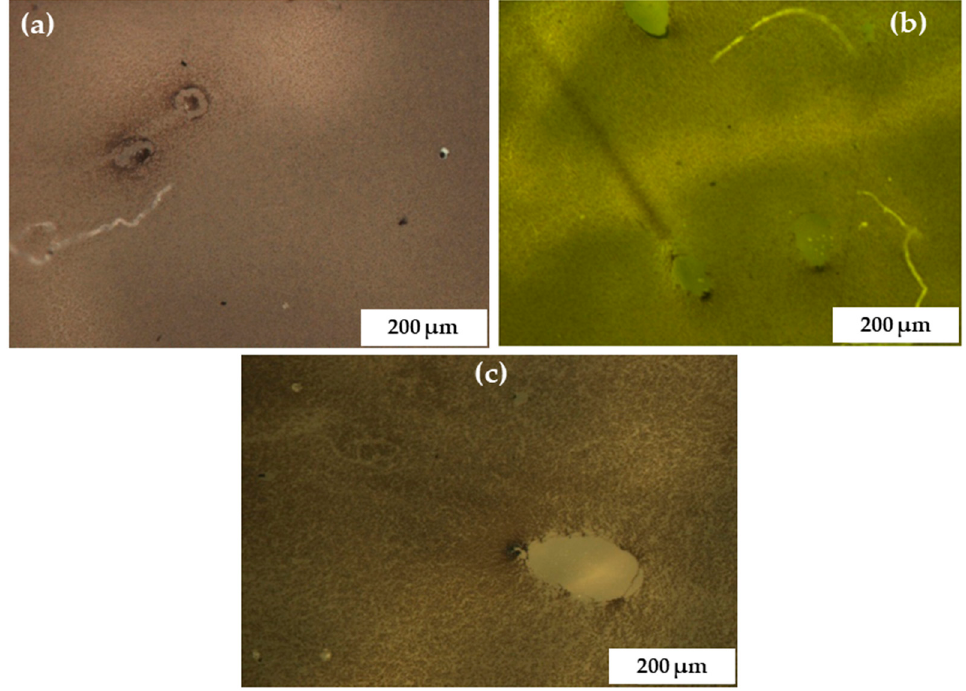
Figure 7. Light microscopic images recorded at calibration 90 of C-N-TiO 2 coated on glass support at a sol gel-solvent ratio varied from 3:5 ( a ), 4:5 ( b ), to 5:5 ( c ), and constant spinning speed of 2600 rpm for 90 s followed by pyrolysis at 350 °C in N 2 (ramping rate of 10 °C /min) for 105 min.